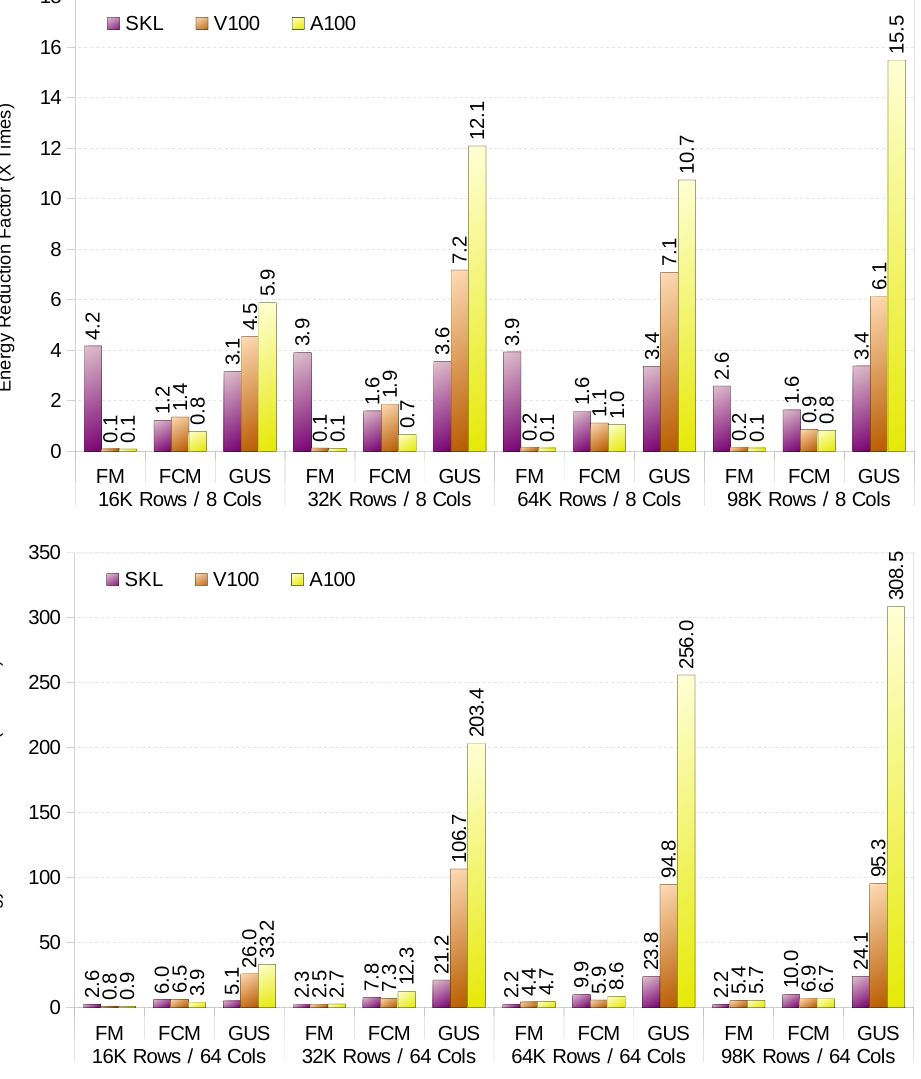
Figure 2. Energy reduction factor (normalised to scalar code running on one